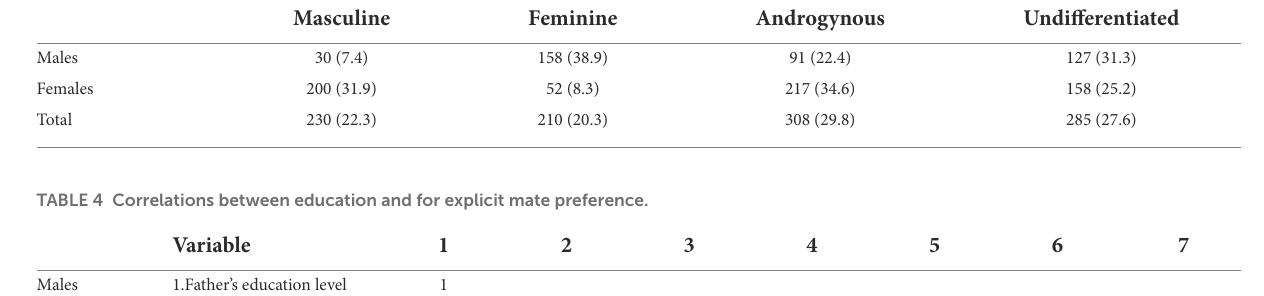
TABLE 3 Mate preference distribution (%).